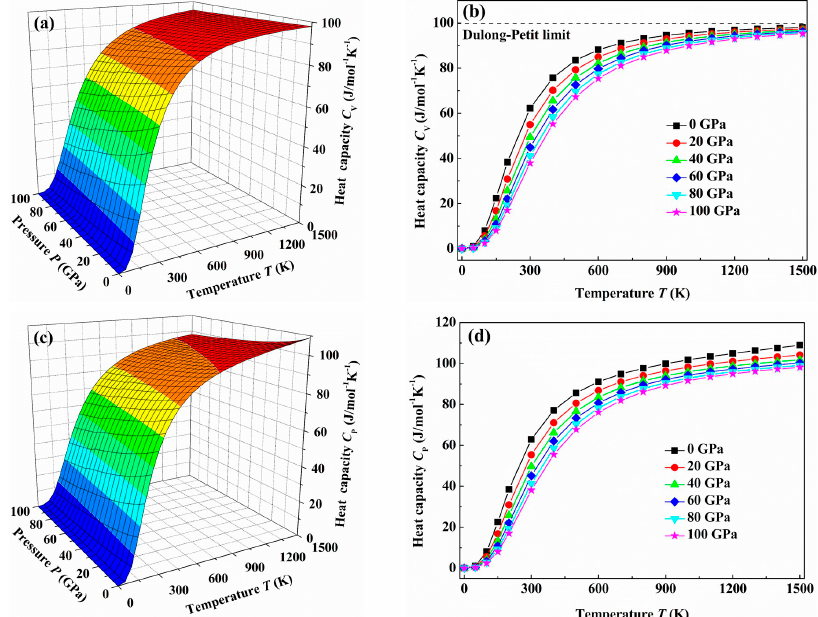
Figure 8. Contours of ELF of the C 2/ m -ZrB 3 on the (001) ( a ) and (102) ( b ) planes at 0 GPa.